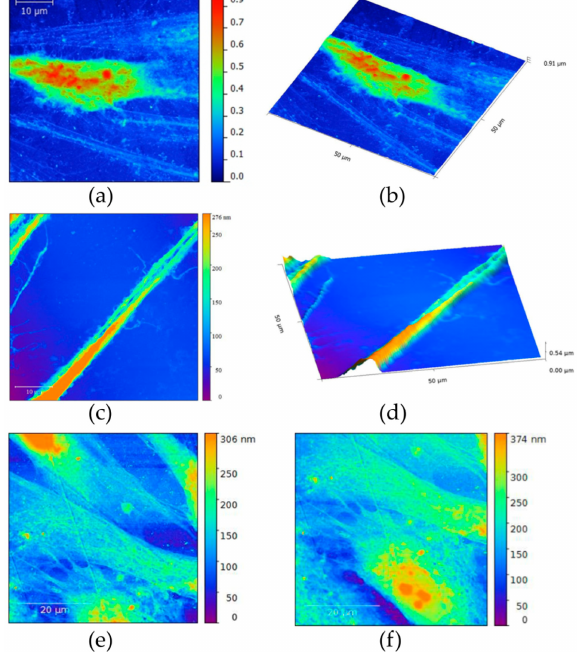
Figure 11. ( a , b ) Atomic force micrographs of SCAP grown on graphene film; ( c , d ) Long, slender projections of SCAP cell membrane covering graphene film; ( e , f ) AFMs of control SCAP grown on PET (control).